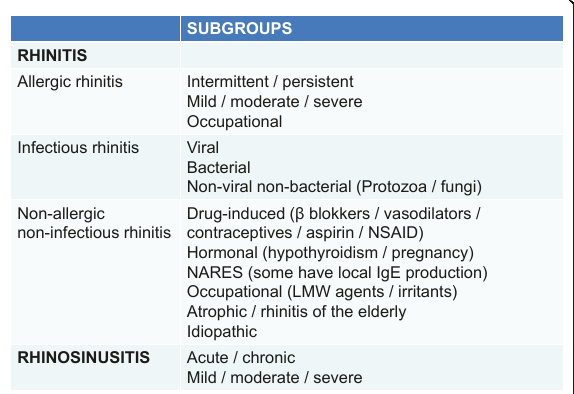
Figure 2 Differential diagnosis of rhinitis/rhinosinusitis